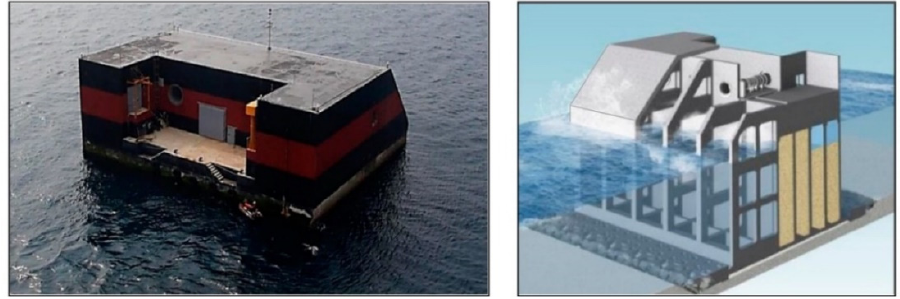
Figure 14. Back ( left ) and perspective views ( right ) of OWC plant at Yongsoo [3].